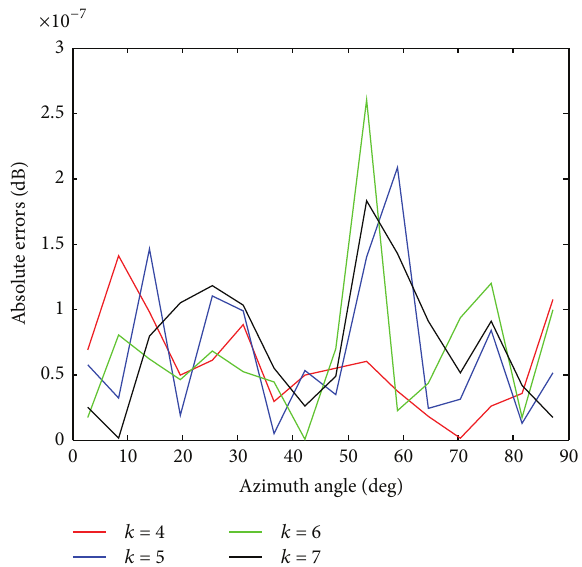
Figure 6: Absolute errors for different 𝑘 and 𝜑 = 45 ∘ .